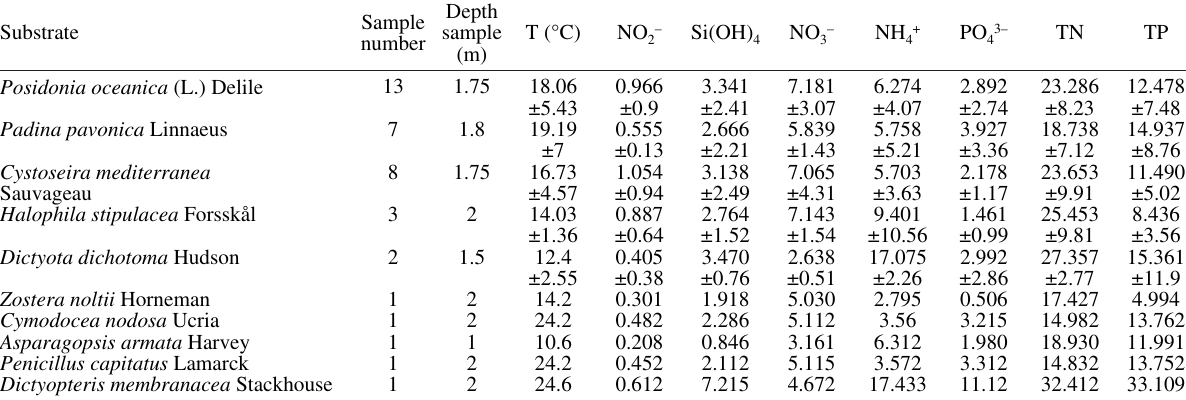
Table 1. – Temperature and nutrient concentrations (in µmol L –1 ) expressed as the mean values (±SD) of the samples taken during the study period. Values without SD correspond to a single record when only one sample was taken.